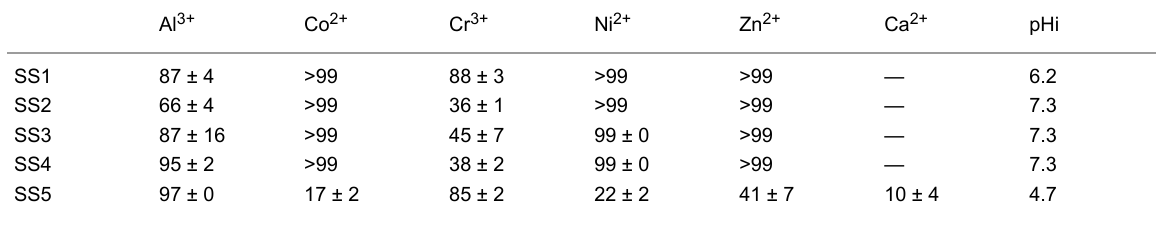
Table 1: Efficiency of activated polyBTCA-CD expressed in % (concentration = 2 g·L − 1 ) to treat several metal spiked solutions SS ( n = 3). See Experi- mental section for the exact compositions of the spiked solutions SS.